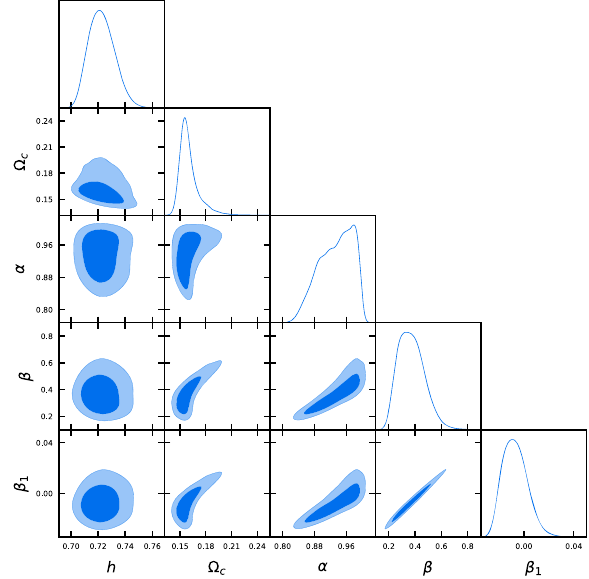
Fig. 3 ContourplotsformodelIMHRDE3withthe1 σ and2 σ regions. We considered the full joint analysis with Pantheon + CC + R19 + BAO + CMB